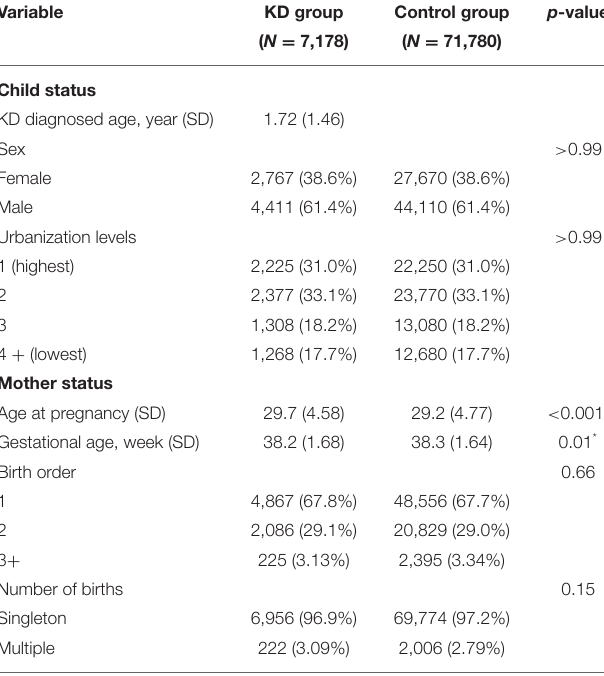
Model adjusted for pregnancy, pregnancy age, autoimmune diseases, and allergic diseases. KD, Kawasaki disease. TABLE 3 | Odds ratio of acquiring Kawasaki disease for children of mothers with immune disorders. Variables